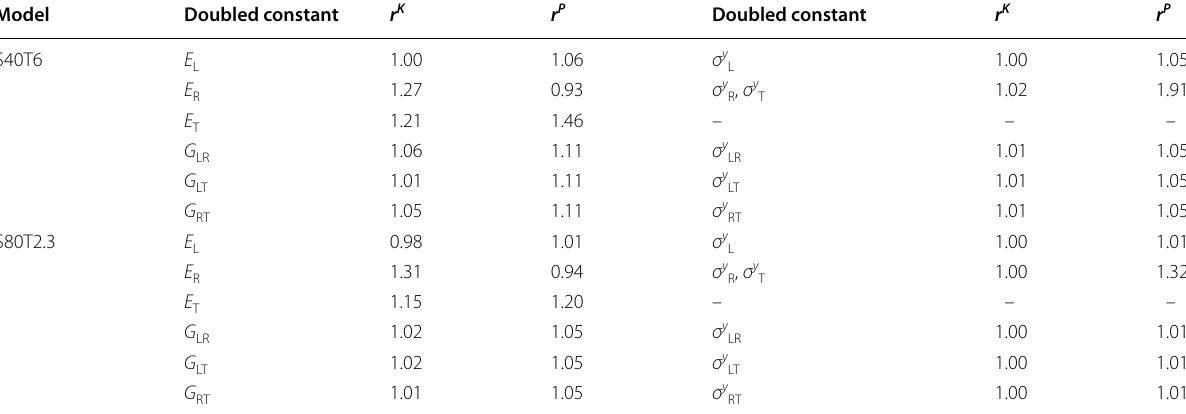
Table 5 Ratio of initial stiffness and yield load before and after changing material constants